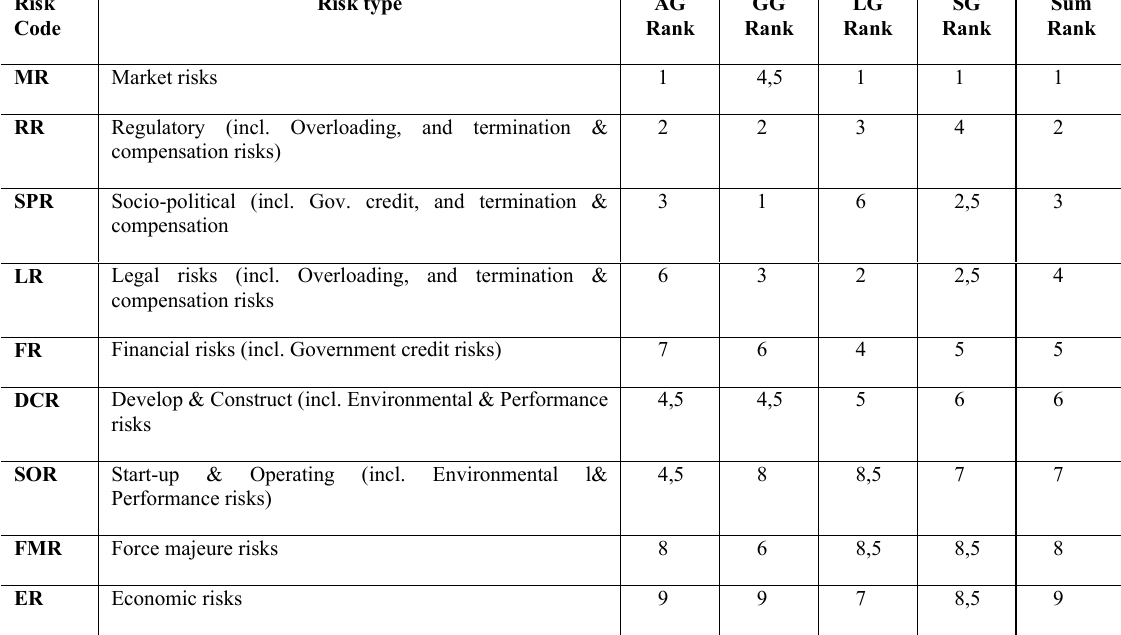
Table 6: Comparative ranking of risks Risk